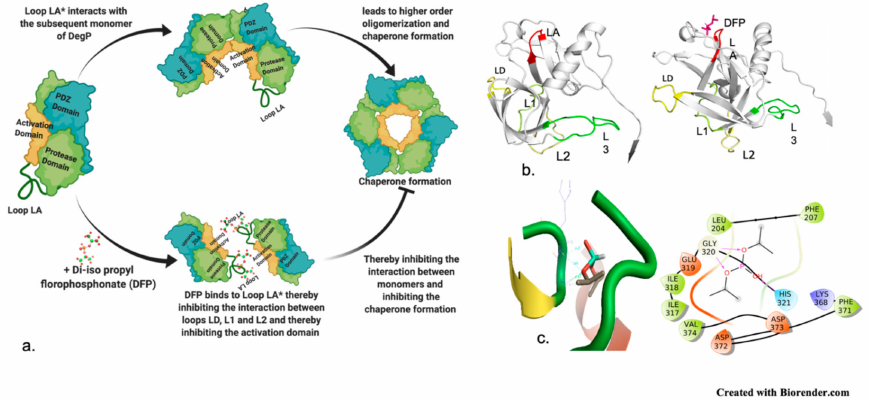
Figure 4. PfDegP activation domains in bound conformation with DFP, a mechanism-based inhibitor of DegP ( a ): Mechanism of Action of Di-iso Propyl fluorophosphate in synapse acting on acetyl- cholinesterase and inhibiting its function of breakdown of choline esters by phosphorylating the crucial serine residue ( b ) cell homeostasis by inhibiting the serine protease DegP by interacting with loop LA (regulatory loop) and inhibiting the activation domain (L1-L2-LD) ( c ) Docked pose of DFP with PfDegP in the least binding energy conformation along with the interacting residues, and interaction diagram of DFP, mechanism-based